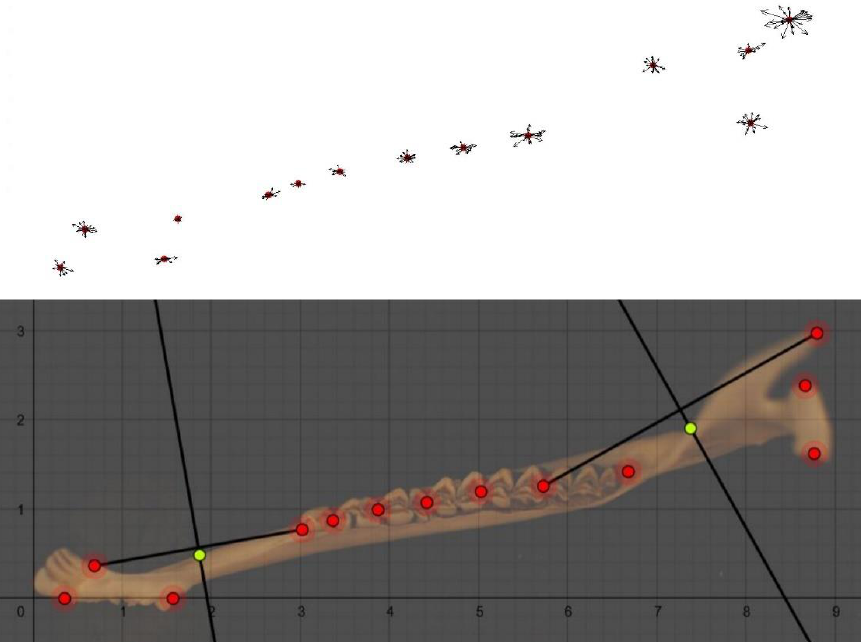
Figure 1. On the top: the consensus configuration for the dorsal side of the mandible (aged 0 – 8 months). On the bottom: the caption of the dorsal side of the mandible (aged 0 – 8 months) from Geogebra. Landmarks are shown in red dots, while semi-landmarks are shown in yellow. Semi-landmarks were placed on the anatomical part encountered by the axis perpendicular to the midpoint of the segment connecting two landmarks.